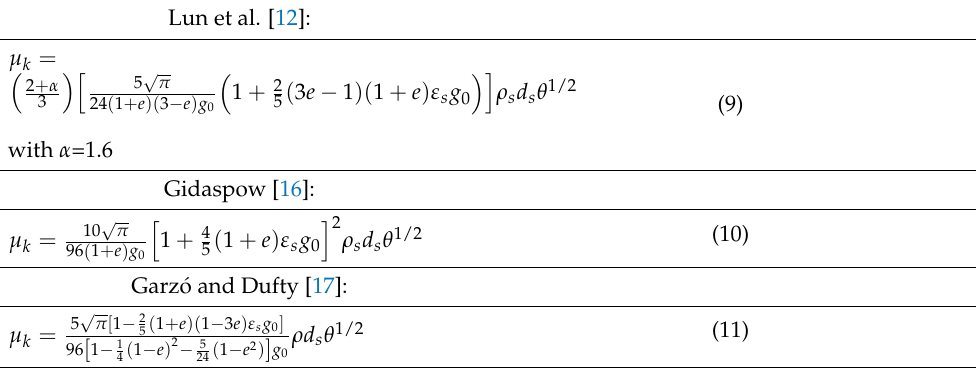
Table 2. Kinetic